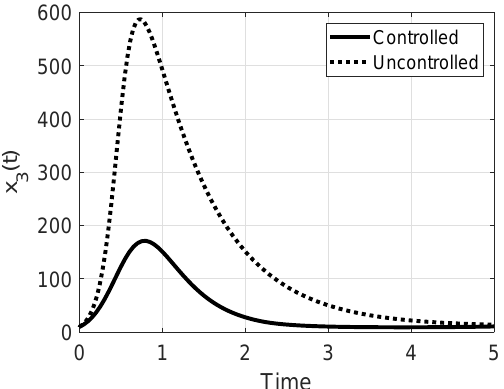
Figure 14. Case 5: evolution of the number of x 3 ( t ) with (continuous line) and without control (dotted line).